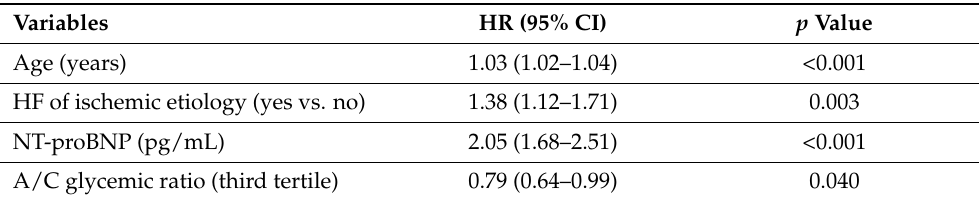
Table 3. Multivariate Cox regression analysis of 4-year all-cause death in the whole population of patients with acute heart